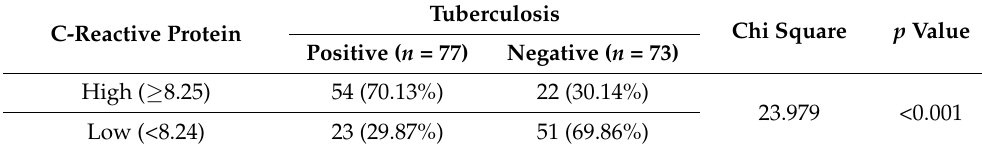
Table 8. Comparison between ideal C-Reactive Protein values and Tuberculosis.